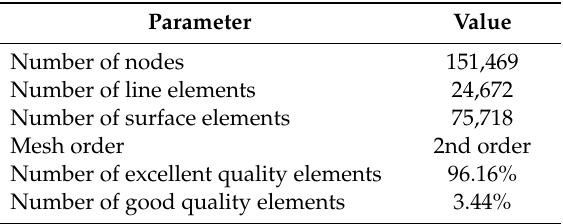
Table 2. Mesh parameters of the FEM model.